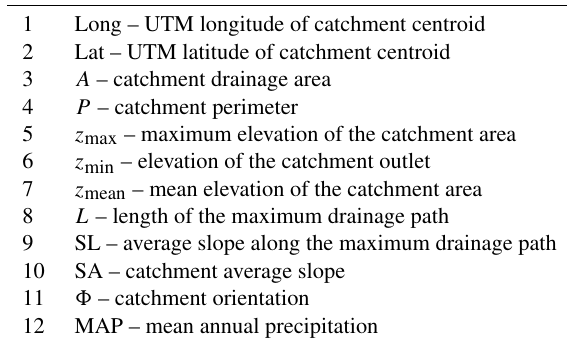
Table 1. Geomorphological and climatic descriptors of the CUBIST database of Italian